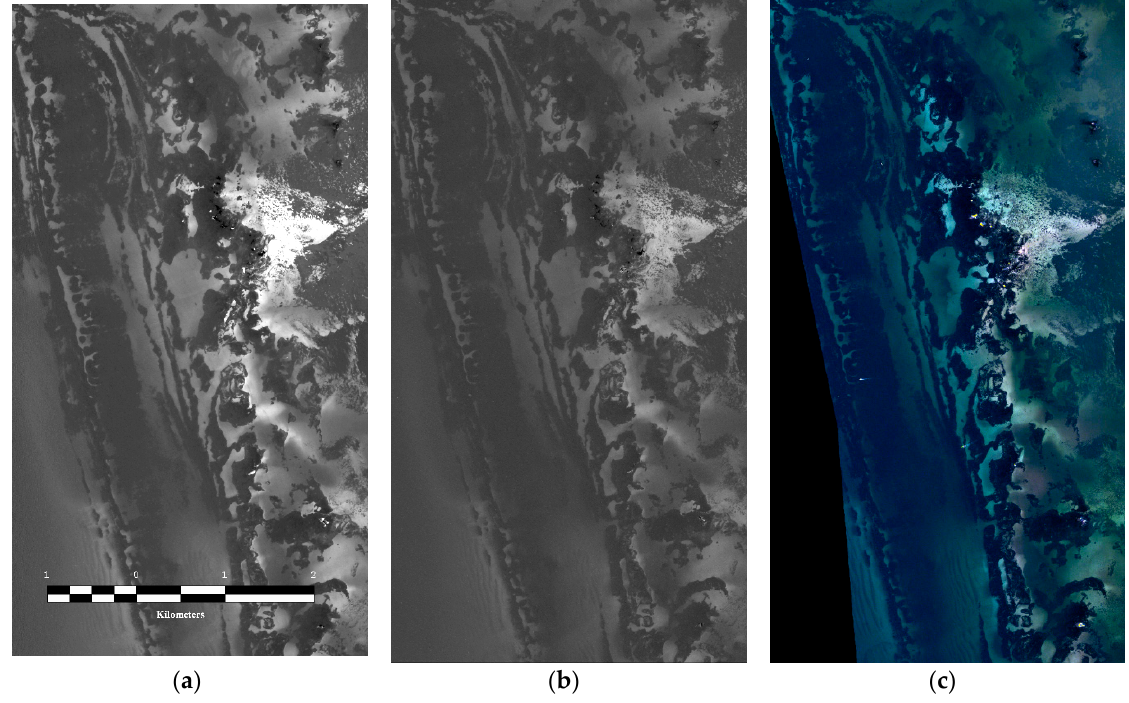
Figure 2. Input data for the study area: ( a , b ) December 2009, Worldview 2 (WV2) (blue band) deglinted stereo pair. ( c ) June 2012 WV2 multispectral image (RGB).